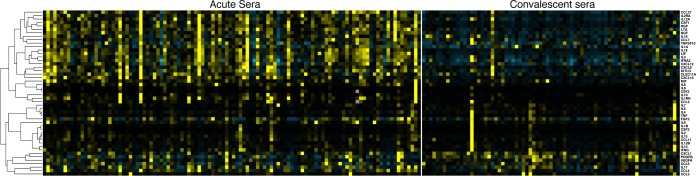
Serum cytokine changes in acute iNTS disease and in convalescence. Shown is a heat map of 48 serum cytokine concentrations in acute iNTS disease (left; n = 108) and in convalescence (right; n = 75). Yellow color change represents increased cytokine concentration relative to the median for all samples, and blue color change represents a decrease. Cytokines are ordered by unsupervised hierarchical clustering, with between-cytokine distances represented by the dendrogram on the left side of the heat map.